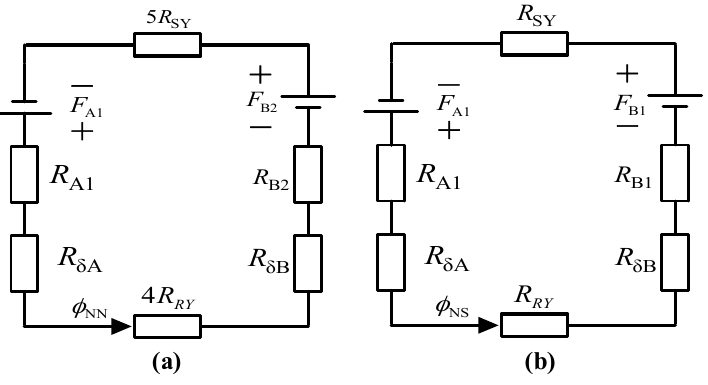
Figure 3. Magnetic circuit of six-phase SRM: ( a ) NN and ( b ) NS. In Figure 3, R SY and R RY are the reluctances of stator yoke and rotor yoke, respectively, R A1 , R B1, and R B2 are the sum of the reluctances stator teeth and rotor teeth corresponding to poles A 1 , B 1, and B 2 and their aligned rotor poles, respectively, R δ A and R δ B are the air gap reluctances of phase A and phase B, respectively, F A1 , F B1, and F B2 are the magnetomotive force excited by the windings on poles A 1 , B 1, and B 2, respectively, and φ is the magnetic